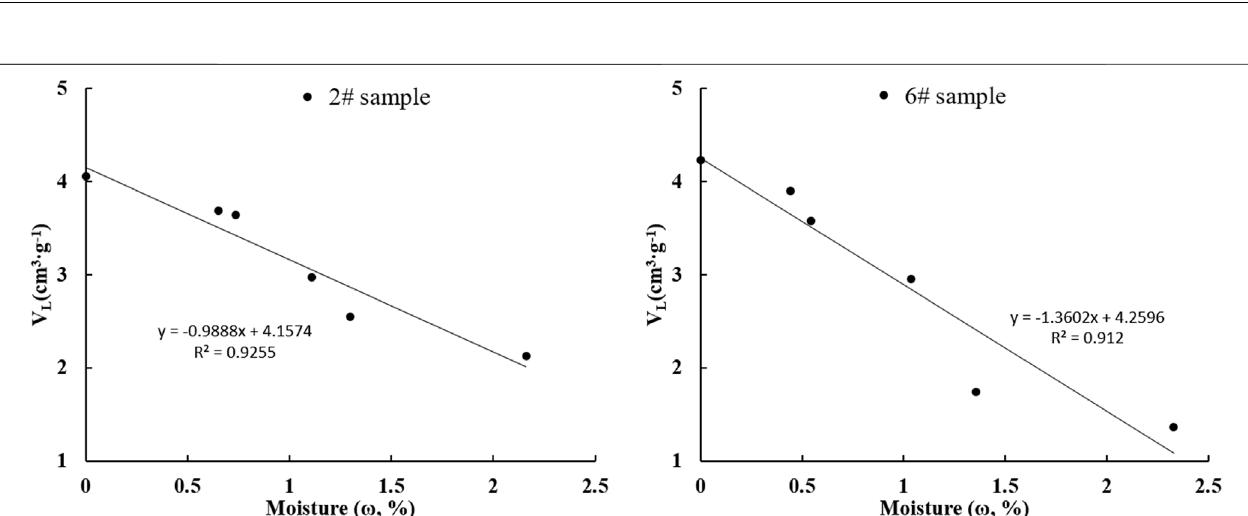
Frontiers in Earth Science |